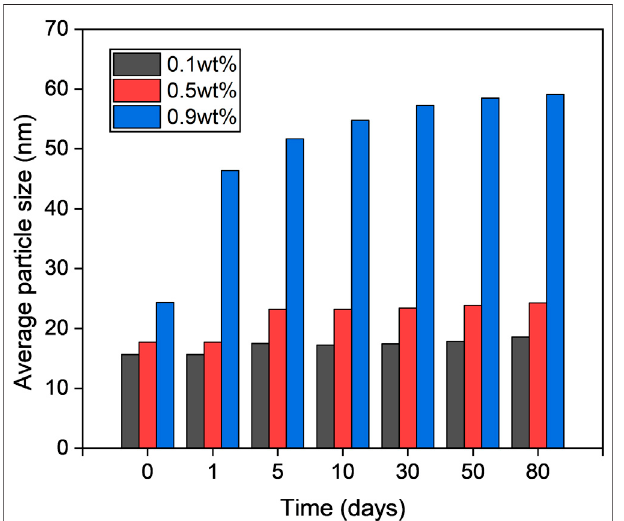
FIGURE 5 | Particle size distribution of the nano fl uid at the test temperature of 70 ° C.